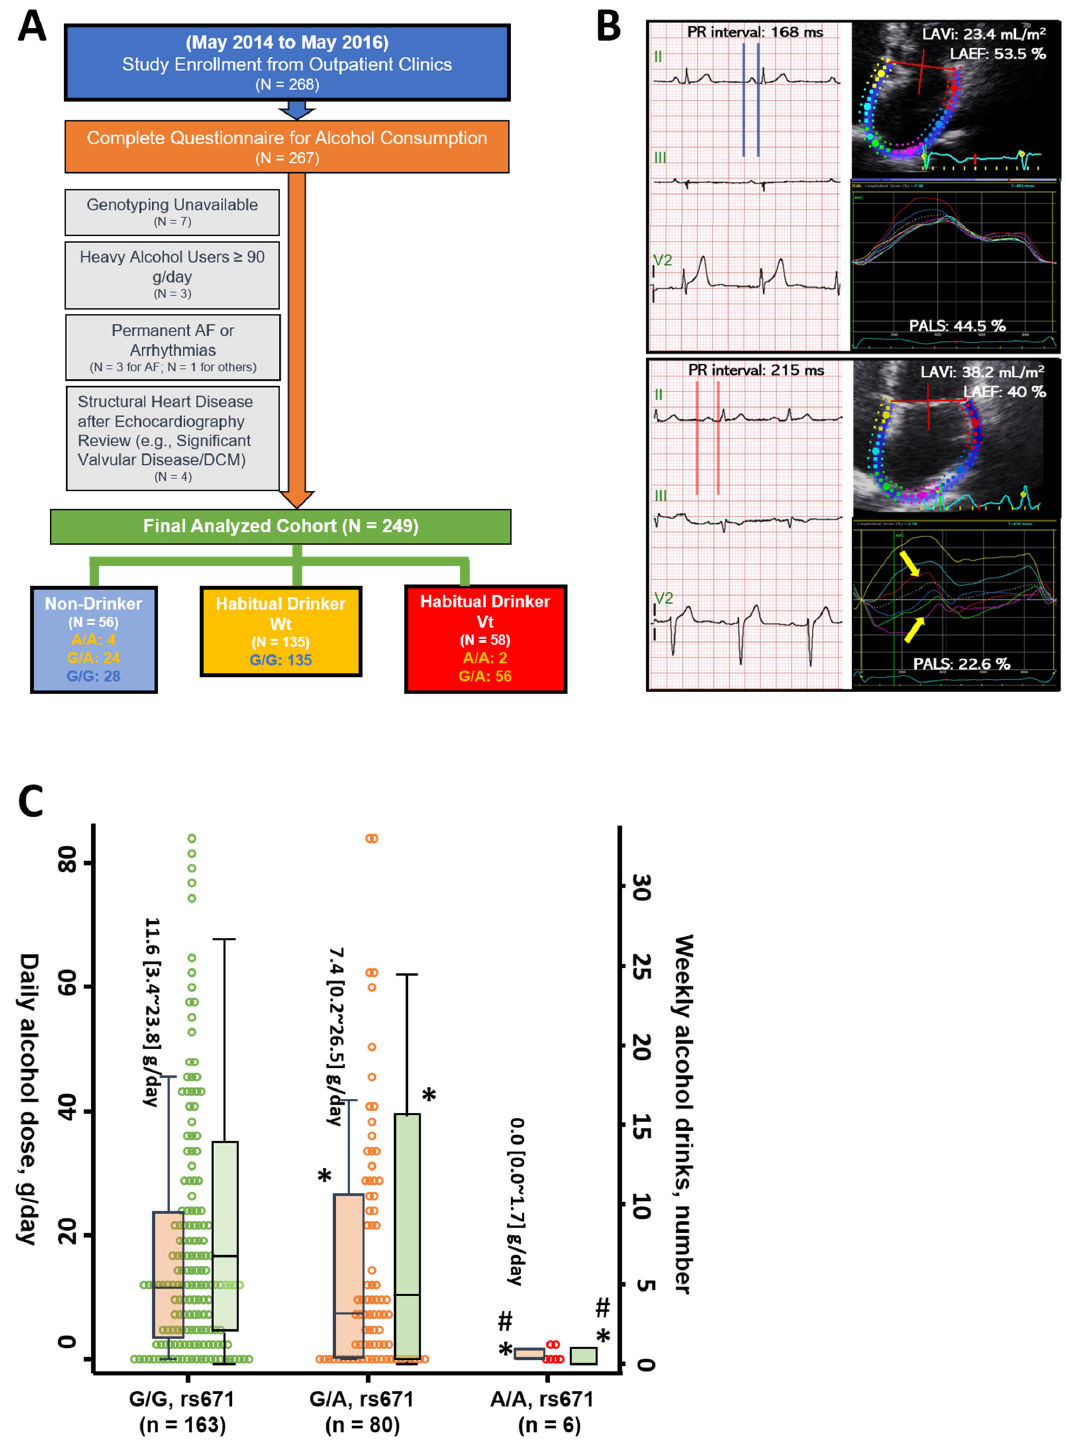
Figure 1. ( A ) Schematic representation of the setting and exclusion criteria of the samples that were included in the present study. ( B ) Illustration of mechanical LA substrates that were used in the present study. A 44-year-old male without a history of regular alcohol consumption (upper panel) demonstrating a normal PR interval with a small LA size and preserved PALS; a 40-year-old male, ALDH2 polymorphism carrier with a history of chronic excessive alcohol consumption (>20 gday), showing a prolonged PR interval accompanied by LA remodeling and impaired PALS. ( C ) Distribution and daily alcohol intake (gday, median level, and IQR) across distinct ALDH2 genotypes as G/G, G/A, and A/A, rs671 (3 groups). One drink is equal to 12 gpure alcohol. Orange bars represent daily alcohol dose (g and green bars represent weekly alcohol drinks, respectively. Both were presented as median and IQR. * p < 0.05 vs. ALDH2 wild type (G/G), # p < 0.05 vs. ALDH2 polymorphism (G/A) via